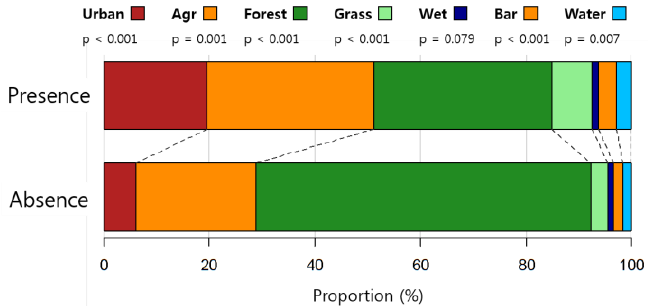
Figure 5. Differences in land cover types between presence and absence sites of Metcalfa pruinosa . The p -value ( p ) was calculated based on the Mann–Whitney U test. Urban: Urban area; Agr: Agricultural land; Wet: Wetland; and Bar: Barren.